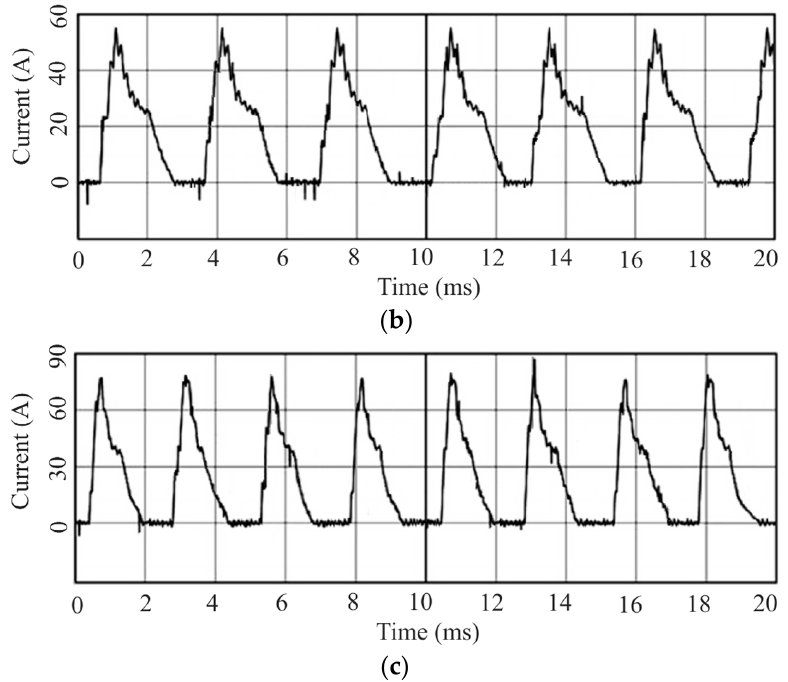
Figure 12. Current waveform of opening angle control at different speeds. ( a ) Current waveform at 1000 r/min. ( b ) Current waveform at 2000 r/min. ( c ) Current waveform at 3000 r/min.